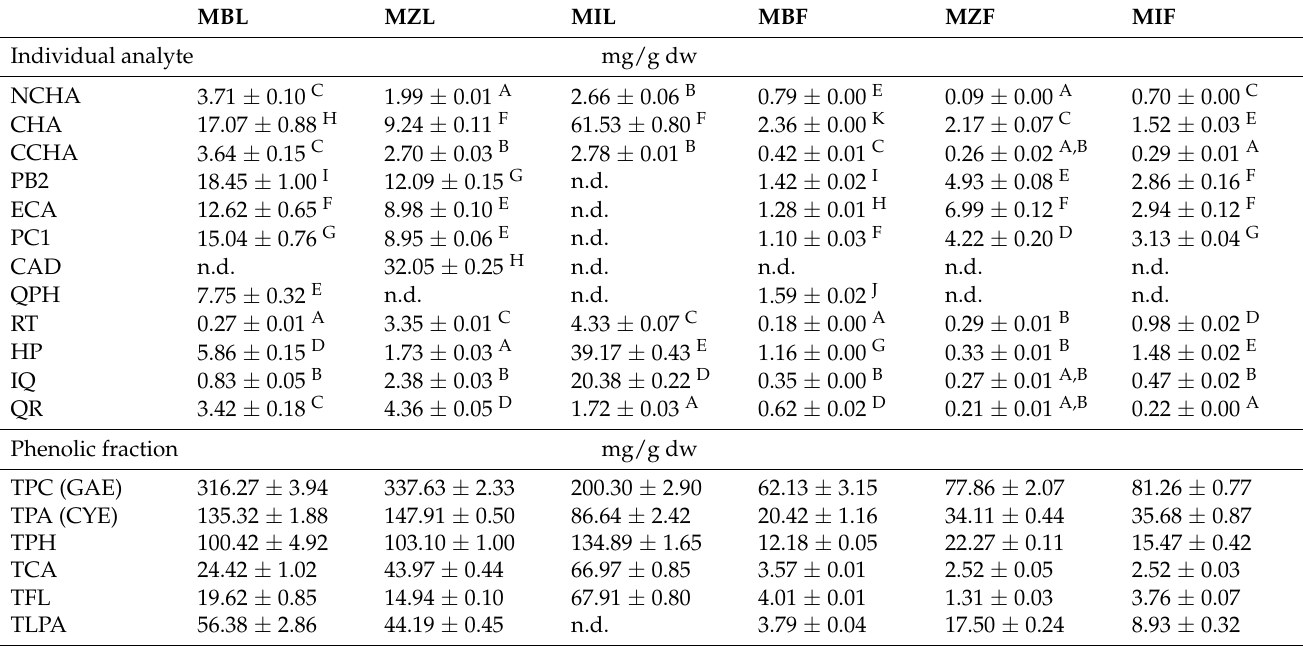
Table 1. The quantitative profile of polyphenols in the methanol–water (7:3, v / v ) extracts of C. bullatus , C. zabelii , and C. integerrimus fruits and